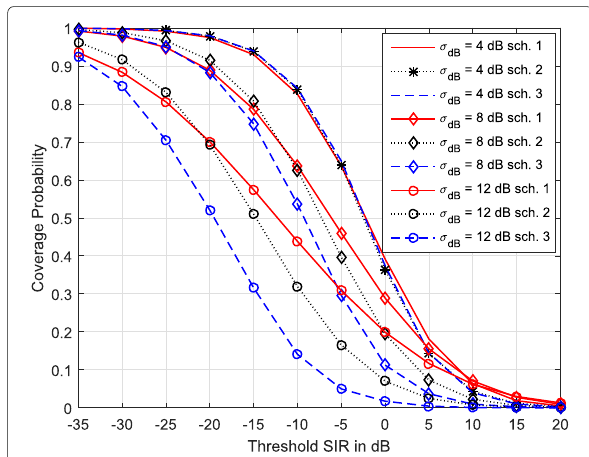
Fig. 2 Comparison of coverage of the three power control schemes for different degrees of shadowing. η = 0.5. λ = 0.5 BSkm − 2 , α = 3.5, = ξ σ dB